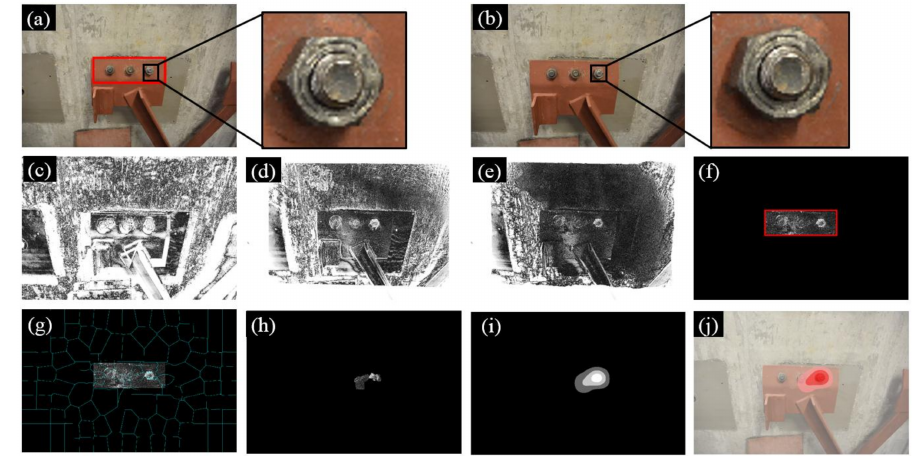
Figure 16. Experimental results under nut loosening: ( a ) Image 1 taken during the first inspection period; ( b ) Image 2 taken during the second inspection period; ( c ) initial errors between Image 1 and 2; ( d ) errors after feature-based image registration; ( e ) errors after intensity-based image registration; ( f ) windowing applied to the registration errors; ( g ) registration errors segmented into superpixels; ( h ) feature enhancement; ( i ) Gaussian filtering; and ( j ) result implementation. The brightness